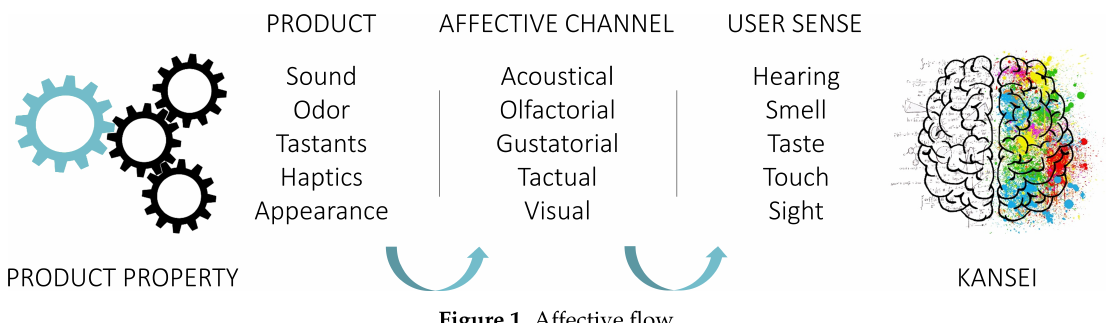
Figure 1. Affective